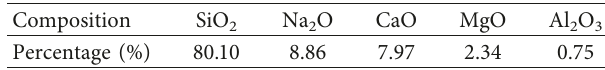
Table 1: Composition and concentration of pure glass powder.